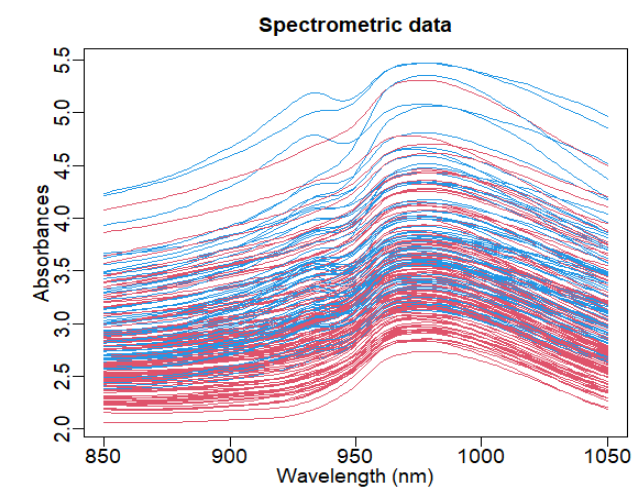
Figure 5. A sample of 100 absorbance curves Z .